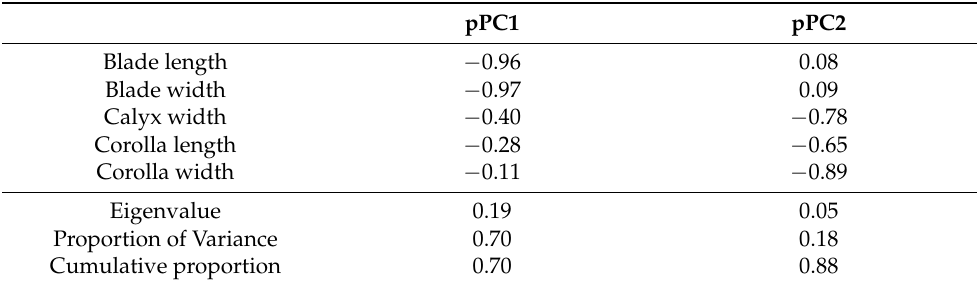
Table 1. Loadings, eigenvalues and variance explained by the two first-principal components from an analysis of 5 morphological traits for 55 Andean Macrocarpaea species. Results displayed are from the phylogenetic PCA based on the MCC